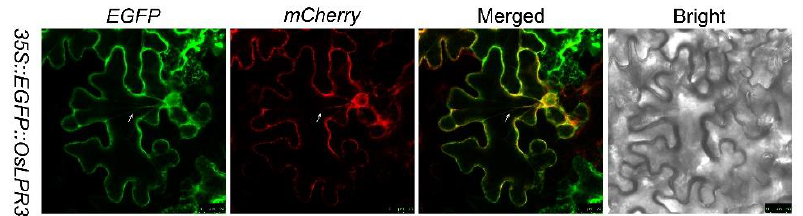
Figure 2. Subcellular localization of OsLPR3. Nicotiana benthamiana plants were infected with Agrobacterium tumafaciens EHA105 containing the reporter constructs 35S::eGFP::OsLPR3 and 35S::mCherry::HDEL . Confocal microscopy was used to capture images of epidermal leaf cells showing transient expression of 35S::eGFP::OsLPR3 (EGFP) and 35S::mCherry::HDEL (CHERRY) . The EGFP and mCherry fluorescence images were merged. A bright-field image is included for comparison. Scale bar = 25 μm.